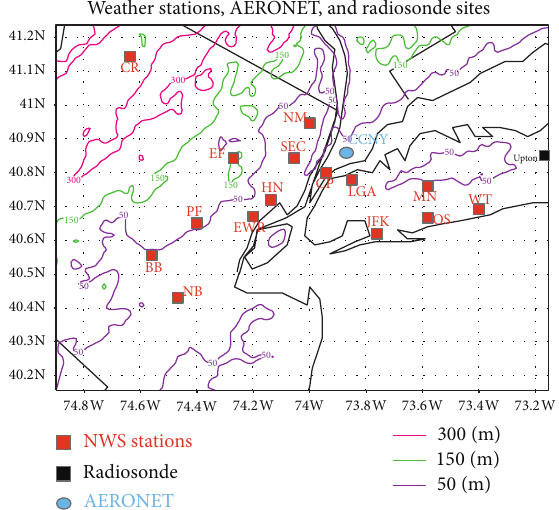
Figure 2: Data sites over topography. NWS surface stations are shown as red squares, the Upton radiosonde site is shown as a black square, and the CCNY AERONET site is shown as a light blue circle.